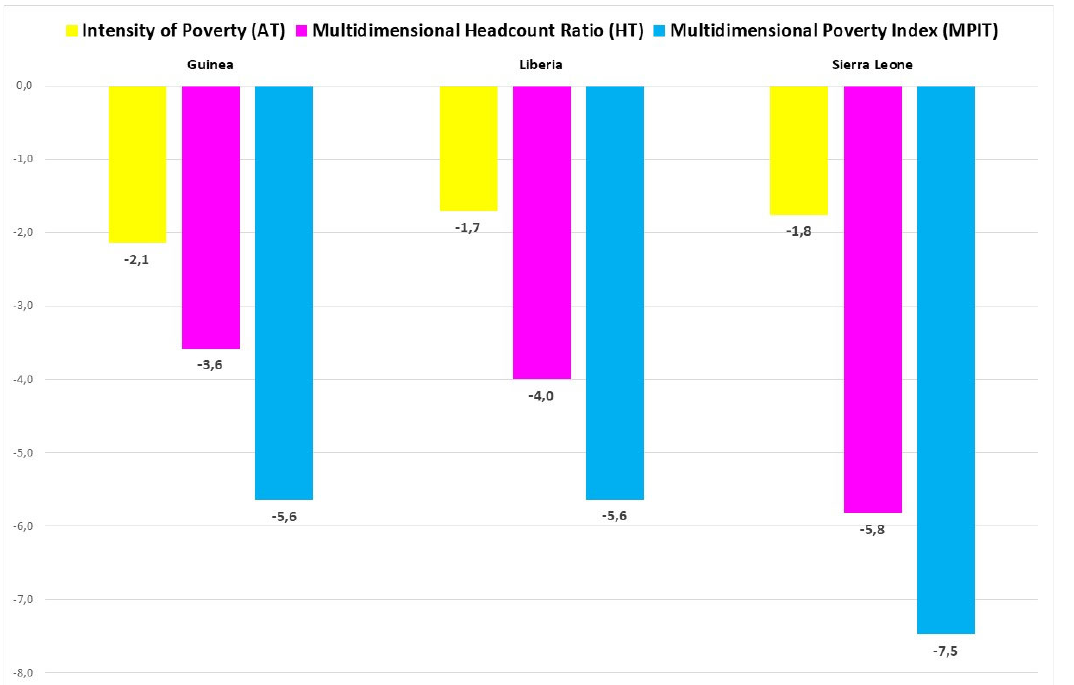
Figure 9. Reduction in the global MPI, and its headcount and intensity. Note: annualized relative changes in the Multidimensional Poverty Index harmonized for comparisons across time (MPIT).